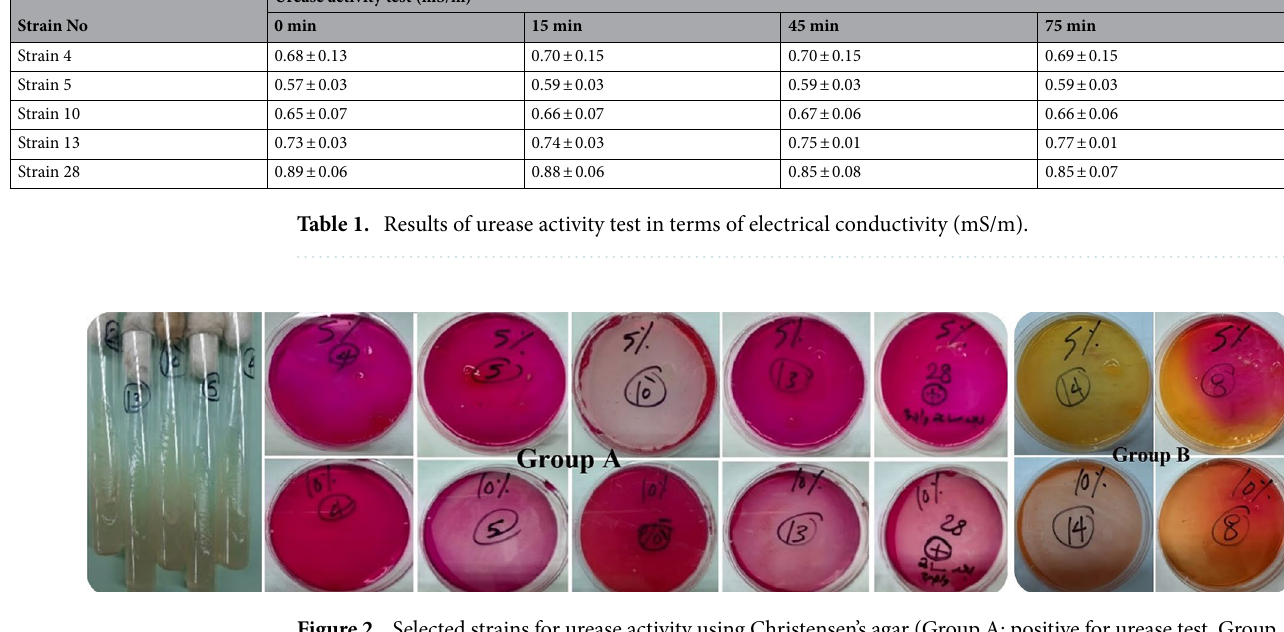
Figure 2. Selected strains for urease activity using Christensen’s agar (Group A: positive for urease test, Group B: ineffective at 5% and 10% urea).